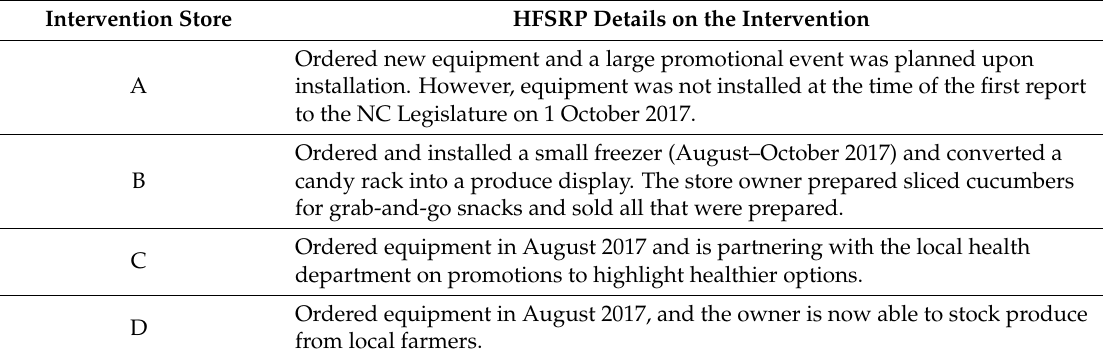
Table 2. Healthy Food Small Retailer Program (HFSRP) stores and details on the intervention. NC: North Carolina.